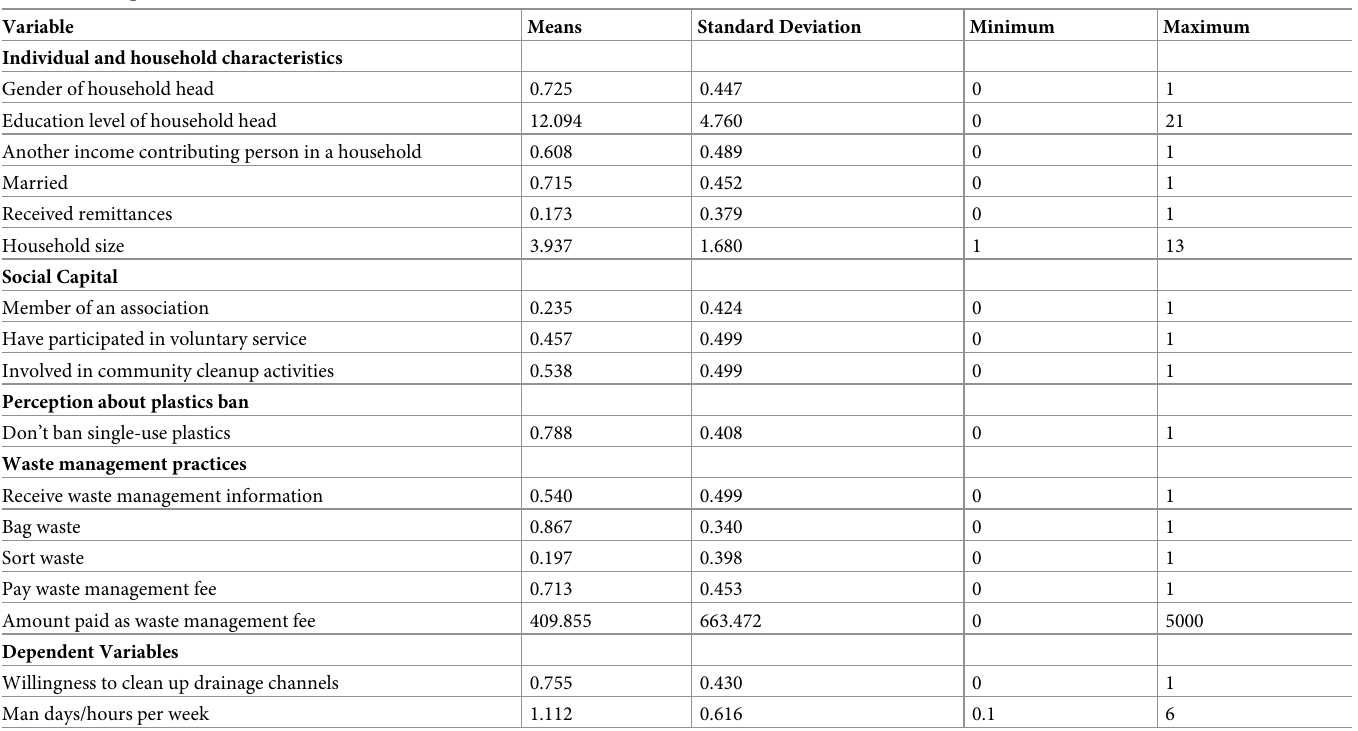
Table 2. Descriptive statistics of variables used in the